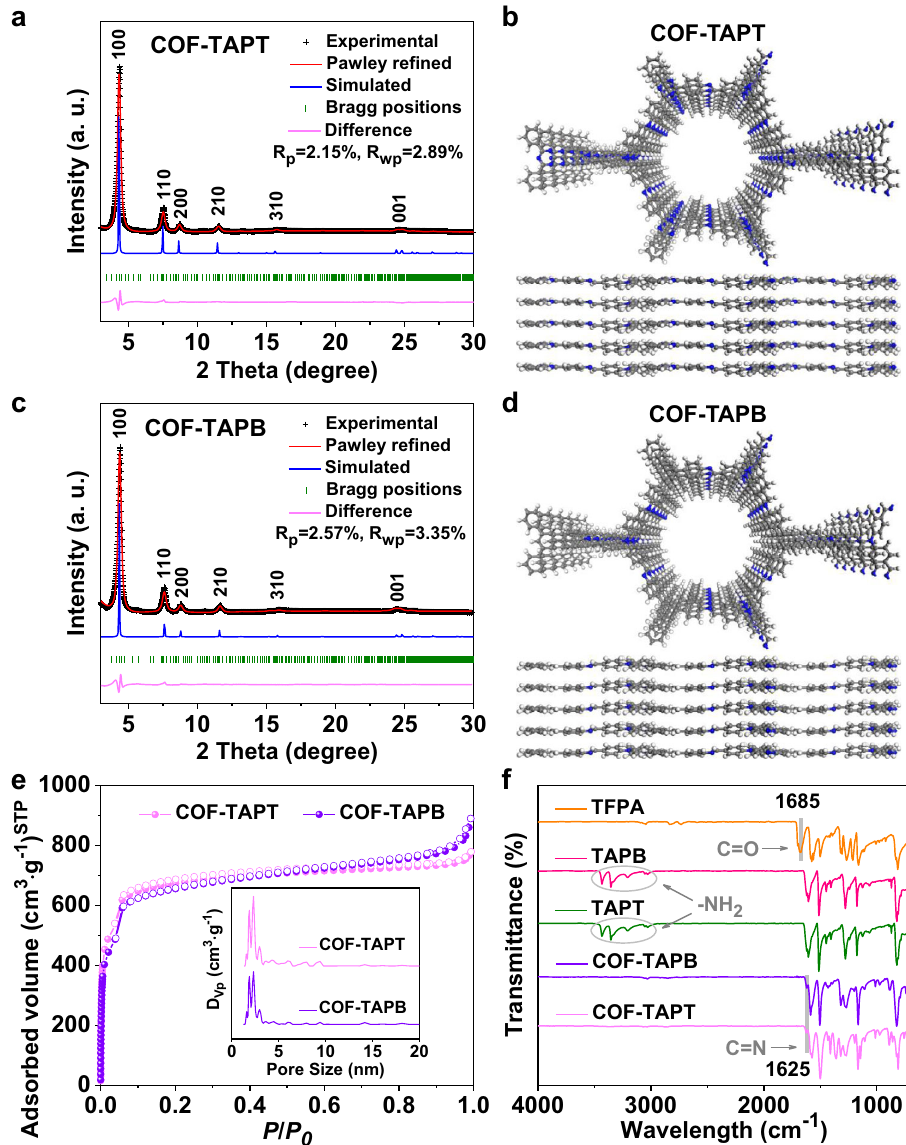
Fig. 2 Structural characterization of COF-TAPT and COF-TAPB. a , c PXRD patterns of a COF-TAPT and c COF-TAPB, with the experimental pro fi les in black, Pawley re fi ned pro fi les in red, calculated (from the re fi ned structure model) pro fi les in blue, and differences between experimental and re fi ned PXRD patterns in pink. Green lines indicate Bragg positions. b , d Re fi ned structure model of b COF-TAPT and d COF-TAPB viewed along the c -axis (upper) and a - axis (lower). e N 2 sorption isotherms of COF-TAPT and COF-TAPB. Inset shows the derived pore size distribution pro fi les of COF-TAPT and COF-TAPB. f FTIR spectra of the synthetic precursors (TFPA, TAPB, and TAPT) and the two COFs (COF-TAPB and